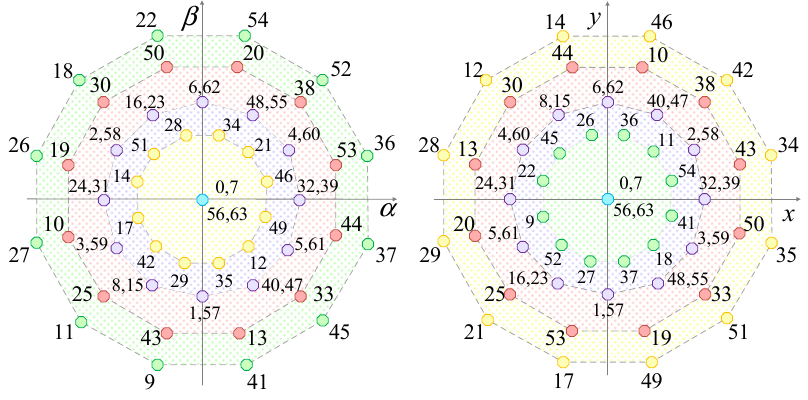
Figure 2. Voltage vectors in α - β and x - y subspaces for an asymmetrical six-phase induction machine fed by a dual three-phase